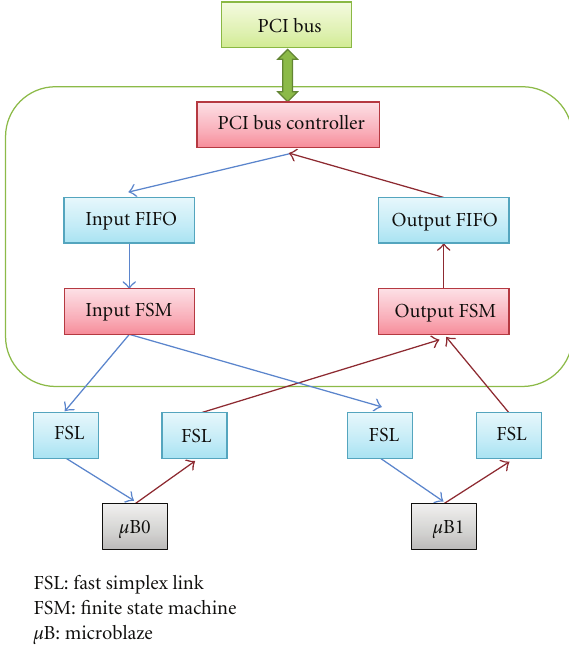
Figure 5: Virtual-IO